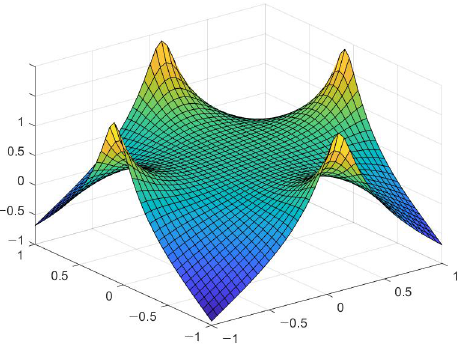
Figure 2. An example of a harmoric function’s surface